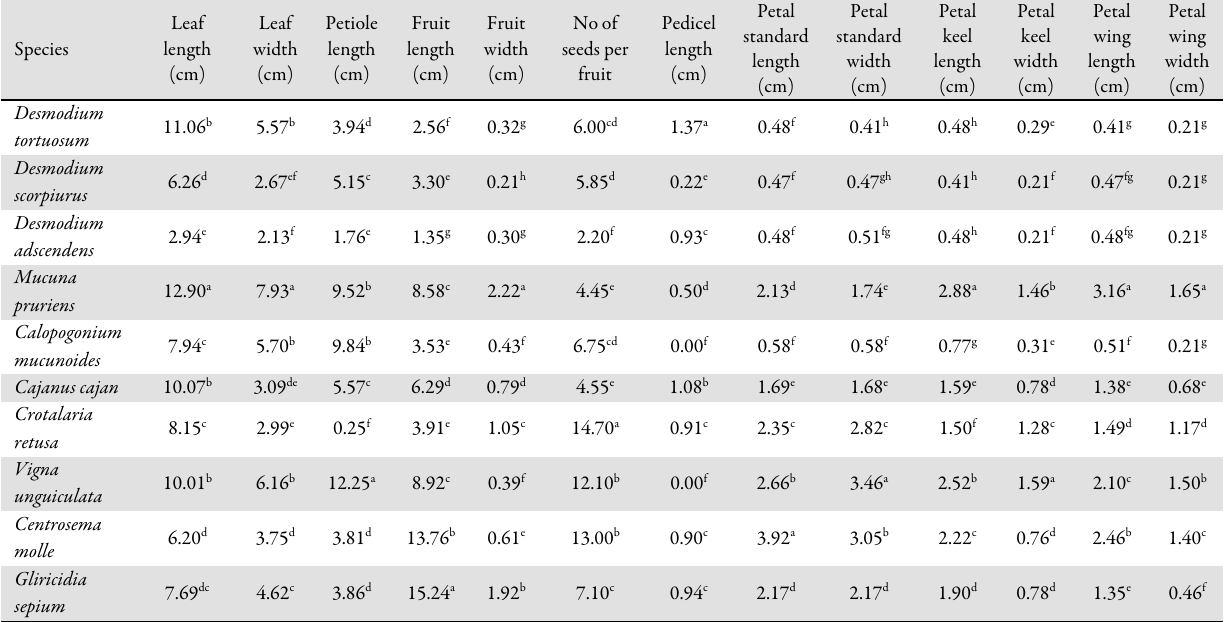
Table 3. Species grouping from Duncan’s multiple range test based on morphology